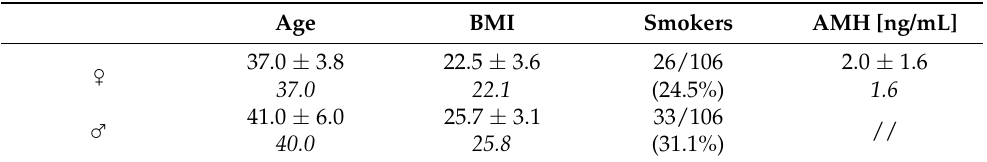
Table 1. The demographic characteristics of the couples and AMH value on the day of oocyte pick-up. Continuous variables are presented as mean ± SD and median (in italics); categorical variables are presented as counts and percentages. Age BMI